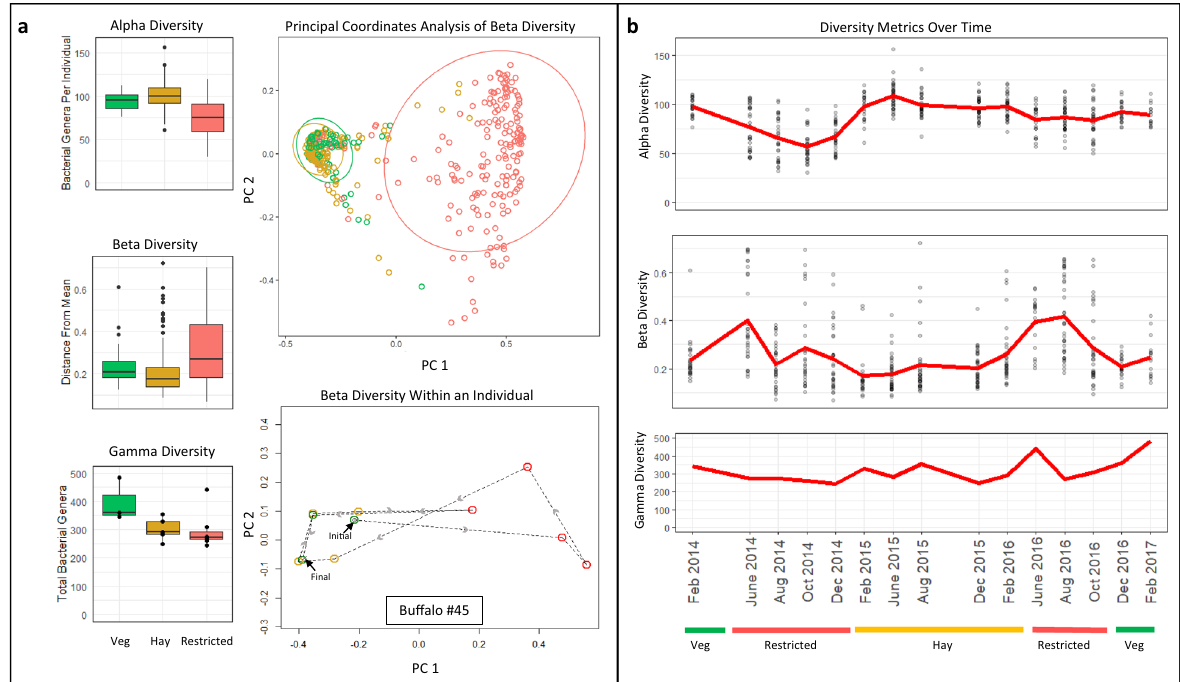
Fig. 2 Microbiome alpha and beta diversity showed opposing patterns of variation across dietary regimes. a Diversity metrics in panel a are colored by feed regime (green indicating green vegetation, yellow indicating hay, and red indicating restricted feed). For each box plot, the lower and upper hinges correspond to the fi rst and third quartiles. The upper and lower whiskers extend from the hinges to the largest and smallest values no more than 1.5 IQR from the hinge. Outliers beyond these points are plotted individually. Gamma diversity did not signi fi cantly change across the three dietary regimes (Kruskal – Wallace p = 0.076, n = 15 time points), whereas alpha diversity was signi fi cantly reduced in the restricted regime compared with hay ( p = 7.12e − 7) and green vegetation ( p = 0.00136) regimes (generalized linear mixed model, n = 426 samples). Beta diversity for each time point was greater in the restricted regime than either the hay (permuted p -value = 0.001) or green vegetation (permuted p -value = 0.002) regimes (permutation test for homogeneity of multivariate dispersion, n = 426 samples). A single individual with near-complete longitudinal sampling (Buffalo #45) was selected to demonstrate temporal shifts at the individual level, with time points connected chronologically by dashed lines. Individual shifts in microbiome composition aligned with population-level shifts in dietary availability. b Temporal patterns in alpha and beta diversity appeared to oppose each other, while gamma diversity remained stable over time. Source data are provided as a Source Data fi le. Table 1 Covariates that signi fi cantly associated with microbiome composition based on the env fi t variable selection analysis and the fi nal CCA